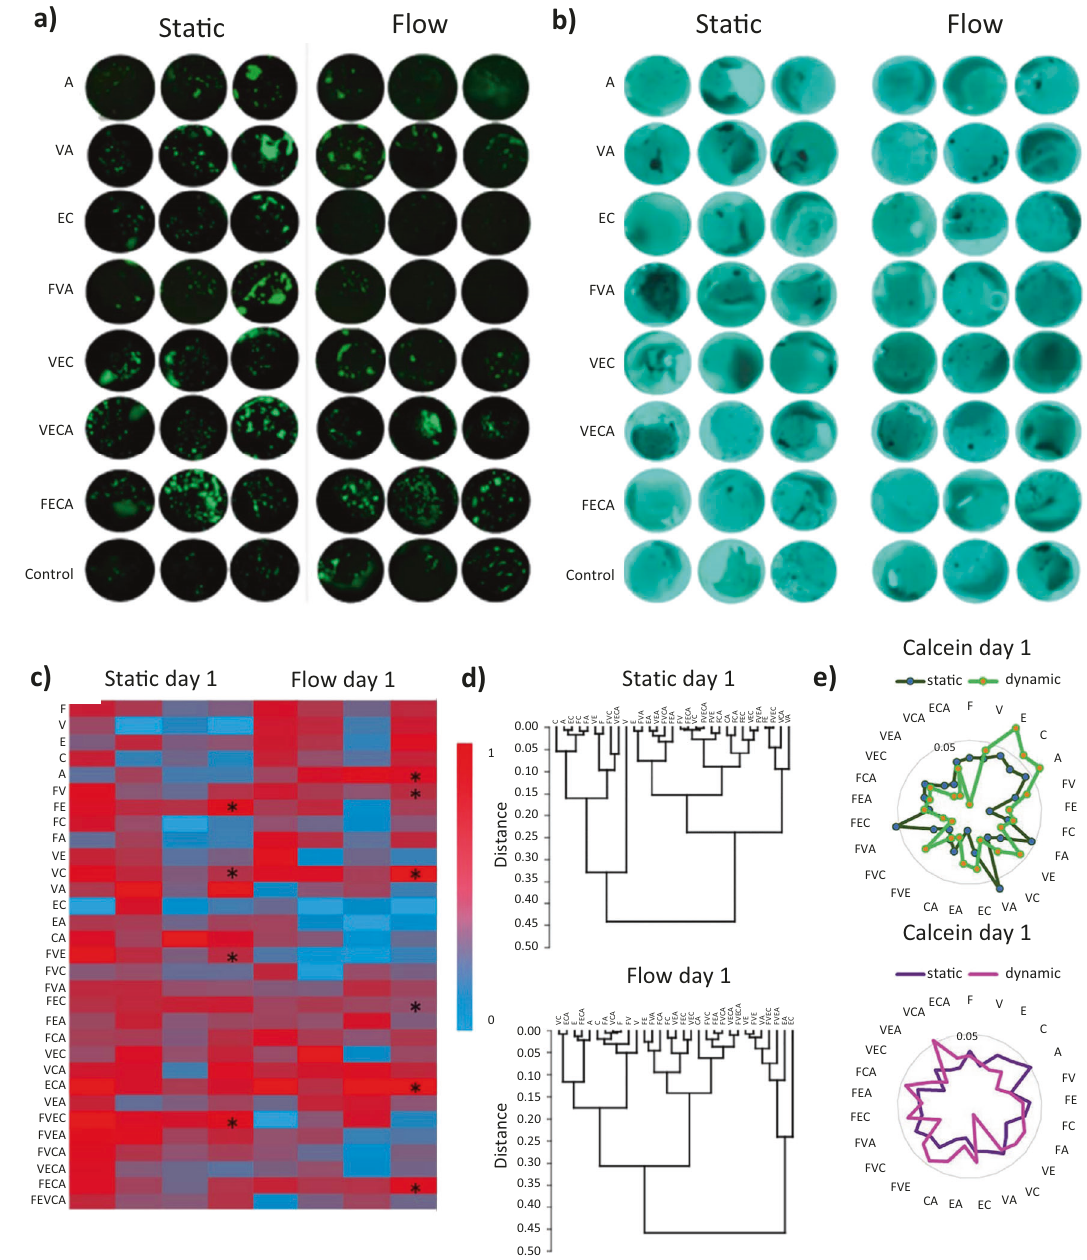
Fig. 4 Fluorescence microscopy images of bone marrow-derived MSCs positive for calcein ( a ) alkaline phosphatase (ALP) ( b ) (in black) on biomaterial formulations rendering highest ALP signal ratios and control (protein-free) conditions, after 1 day of cell culture. c Heat map representation of ALP present in all scaffolds cultured under static and dynamic conditions, for 1 day of cell culture. d Dentograms with hierarchical clustering of the average cell viability values for each formulation and combination of materials. e Calculated effects of a 3-factor model for each protein and protein combinations in ALP production and detected calcein under static and dynamic culture conditions. This fi gure was reproduced with permission from Elsevier (2020) contain integrin binding motifs, which can be utilised for cell mesenchymal stem cells. 275 Fibronectin and fi bronectin-derived adherence and promote cell – material interaction to induce oligopeptides have been shown to activate Erk signalling path- distinct biological activities through cellular signalling pathways way, which involves in the chondrocyte, osteoblast and osteoclast and ensure mechanical stability in the tissue. differentiation. 276 Tropoelastin, the precursor molecule of elastin, Decellularised tissue products have become well established, interacts with the cells in ECM via elastin-binding receptors such exempli fi ed by the success of decellularised tissues to create heart as elastin binding protein, integrin and GAGs. 277 These interac- valves used in valve replacement surgeries. This technology has tions enable the tropoelastin molecule to mediate cell differentia- seen many successes as well as failures. Bovine and porcine tion, chemotaxis, and proliferation. 278 Coating of Ti/Zi metal alloys bioprostheses have seen promising results in patients with with tropoelastin has resulted in improved adherence of medium-term follow-up. 280 On the other hand, translation to osteoblasts and osteointegration of the implant. 279 ECM molecules